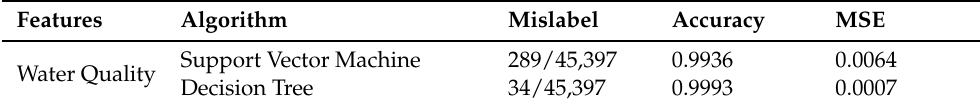
Table 5. Evaluation of water quality monitoring classification